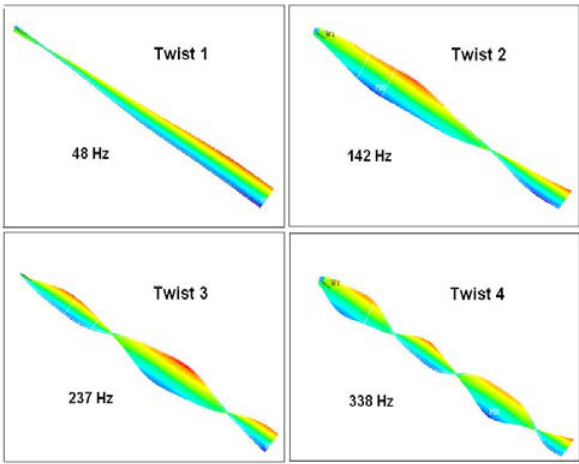
Fig 3. Twist mode shapes of an aluminum plate with piezoelectric actuators